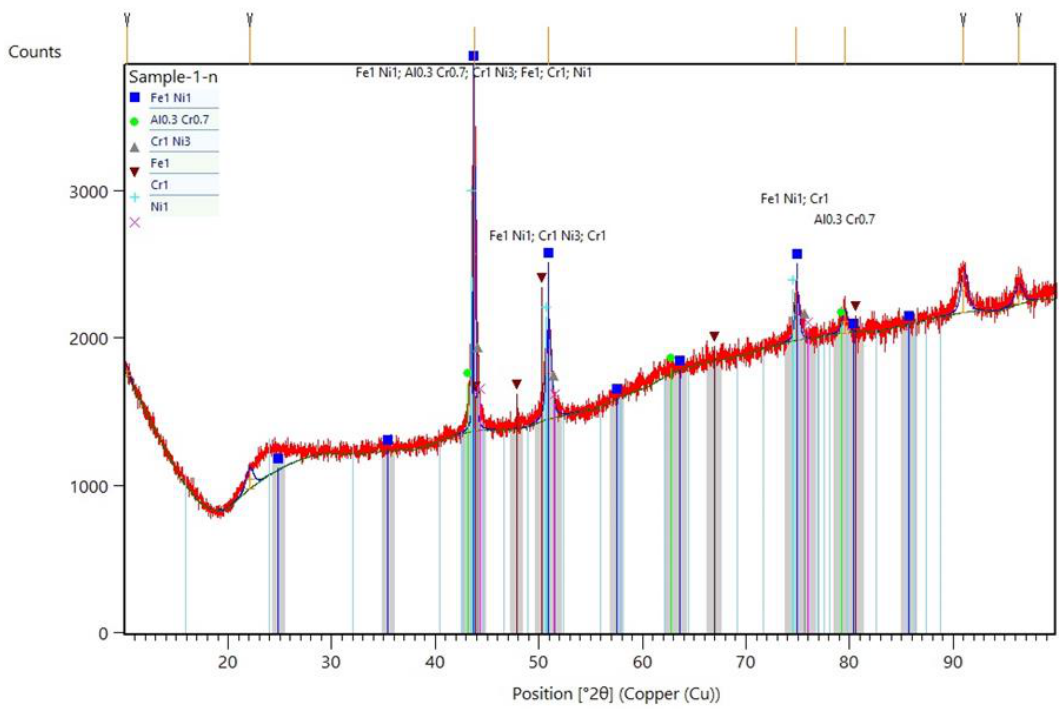
Figure 7. XRD analysis of the samples, demonstrating the presence of individual main elements including Fe, Cr, Ni and the intermetallic compounds.